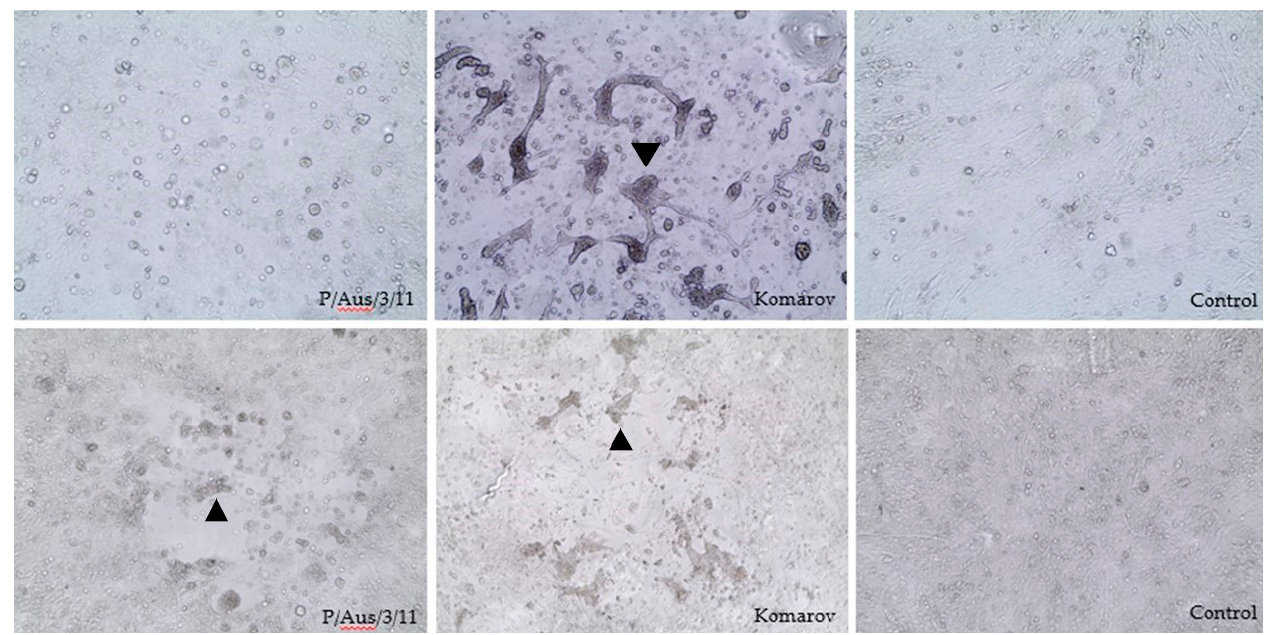
Figure 1. Cytopathic effect (arrowheads) in inoculated chicken embryo fibroblast with P/Aus/3/11, Komorov and CEF control with (bottom three) and without (top three) the addition of carboxymethyl-cellulose in the absence of trypsin (10×).